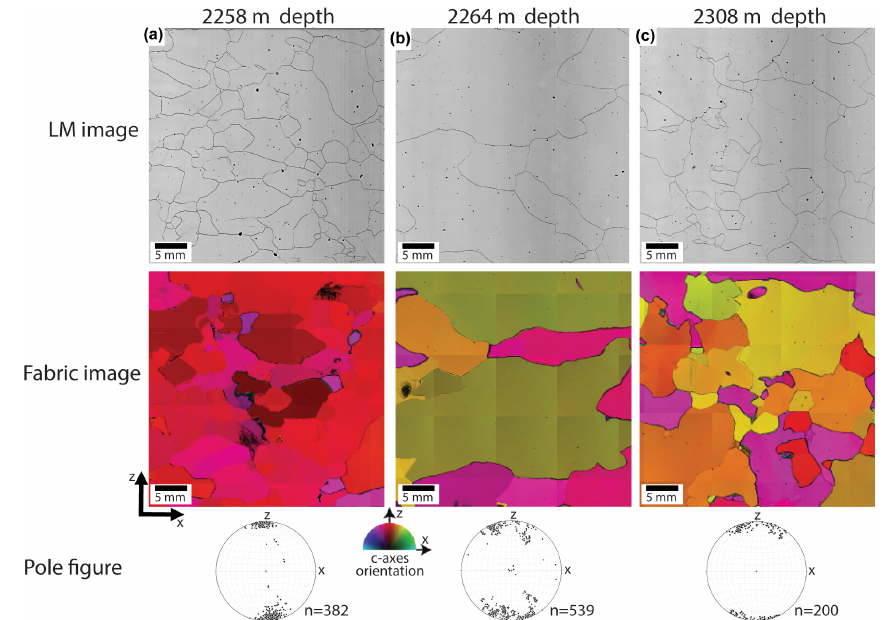
Figure 2. The LASM, FA images and pole figures from three different ice core sections in the Eemian-glacial facies. The ice core sections in (a) and (b) are just above (2258m depth) and below (2264m depth) the stratigraphic disruption at 2262.2m depth, while (c) is from the middle of one of the overturned layers (2308m depth). The z axis is parallel to the (vertical) ice core axis. The number of grains n included in the whole (90 × 55mm) orientation (fabric) image and pole figure is provided next to the pole figure (equal area, vertical plane, one point per grain). The pole figure in (b) contains the c -axes data from six consecutive ice core sections to increase the number of grains in the pole figure. LM images are taken from Kipfstuhl (2010) (https://doi.pangaea.de/10.1594/PANGAEA.743296). Fabric images and pole figures are taken from Weikusat and Kipfstuhl (2010)